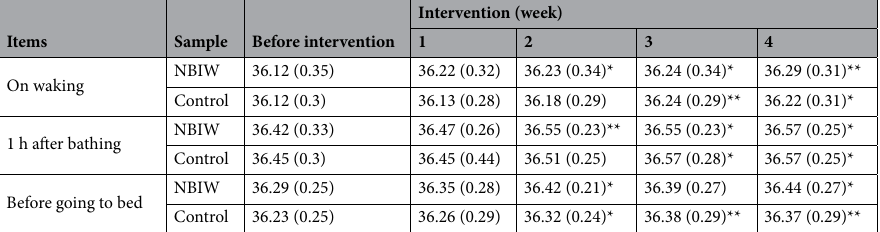
Table 3. Body temperature. NBIW neutral bicarbonate ionized water. NBIW: n = 25, Control: n = 27. Values are shown as mean ( SD ). Within-group comparison: Significant differences were found compared with before the intervention (* p < 0.05, ** p < 0.01: Wilcoxon signed rank test). Between-group comparison: No significant differences were found compared with the control group (Wilcoxon rank sum